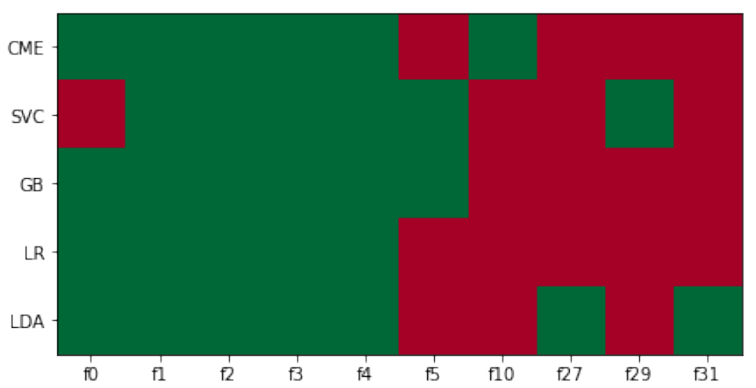
Figure 2. Results of the IVI algorithm for each ML technique on the synthetic dataset. In rows are the different ML techniques: covariance multiplication estimator (CME), support vector machine classification (SVC), gradient boosting (GB), linear regression (LR), and linear discriminant analysis (LDA). In columns are the different features, as defined previously. Green stands for scenarios where features were identified as relevant. Red stands for features not identified as relevant during the